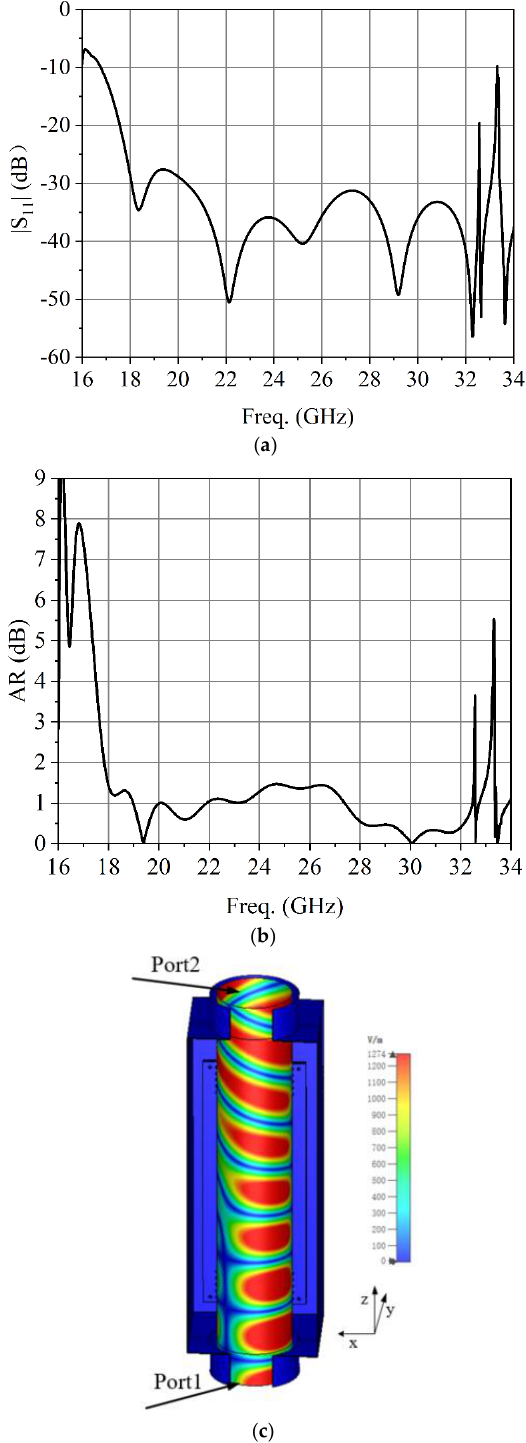
Figure 5. Simulated results of the dielectric plate circular polarizer: ( a ) Reflection coefficient. ( b ) AR. ( c ) E -field distribution in the circular polarizer at 25 GHz.